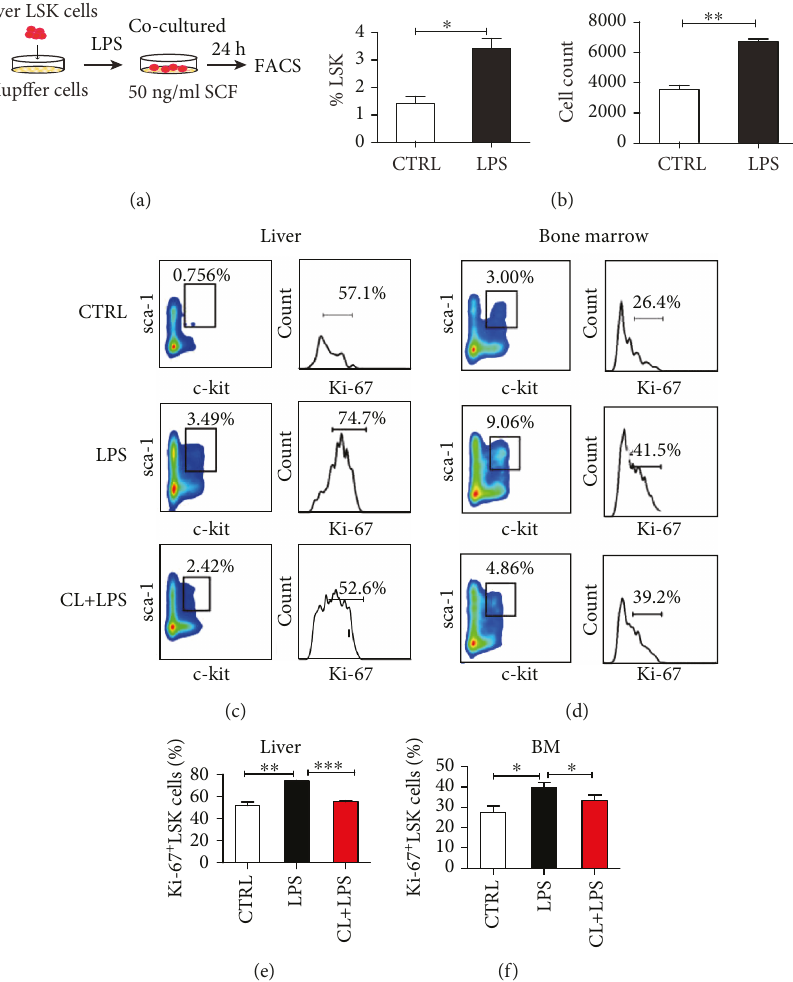
Figure 5: Kup ff er cells can promote liver LSK cell proliferation. (a) A schematic map of the kup ff er and LSK cell coculture. Freshly isolated kup ff er cells were stimulated with 1 mg/mL LPS for 6 h, then cocultured with freshly sorted LSK cells for 24h. (b) Statistical analysis of the percentage and absolute number of LSK cells among the mononuclear cells in the coculture system with or without LPS treatment. (c – f) An LPS-induced liver extramedullary hematopoiesis model was established with or without kup ff er cell depletion. The proliferation of LSK cells in the liver and bone marrow was determined by Ki-67 labeling in the di ff erent treatment groups by fl ow cytometry. Mean ± SEMs from three independent experiments are presented ( n = 3 ‐ 5 ). ∗ P < 0 05 ; ∗∗ P < 0 01 ; ∗∗∗ P < 0 001